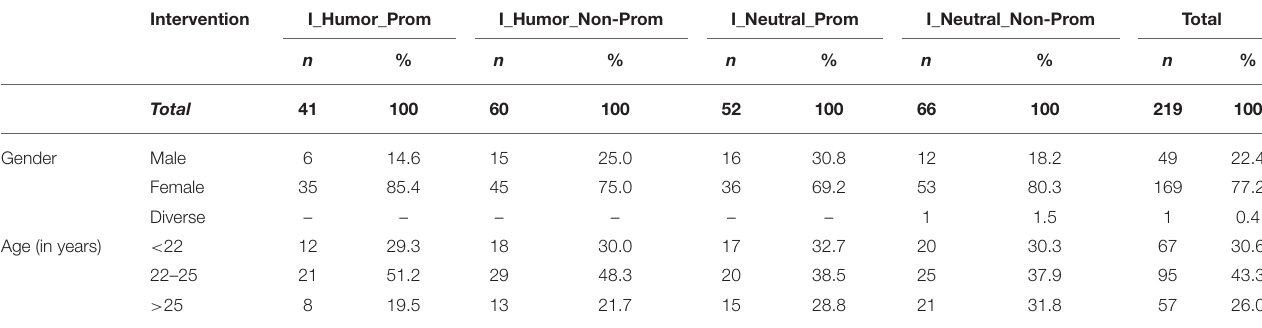
TABLE 1 | Sample characteristics at baseline ( n =